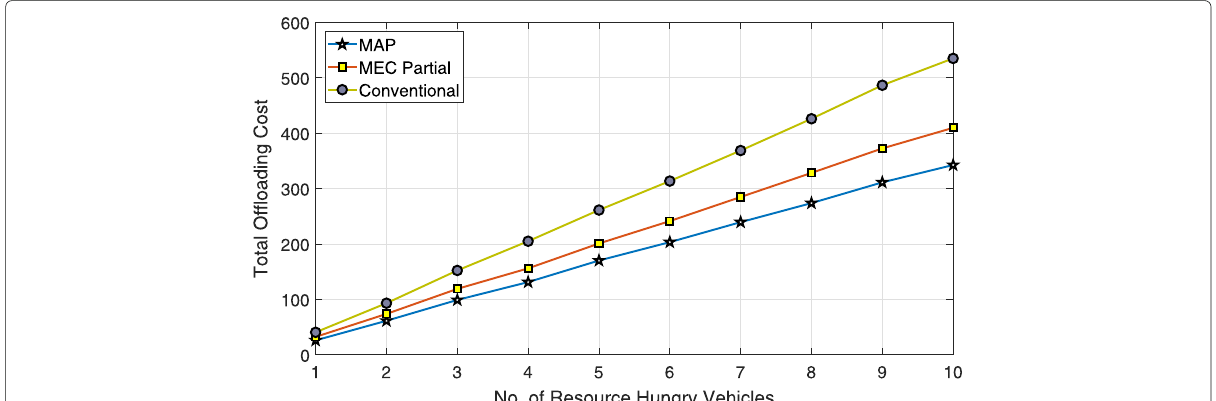
Fig. 2 The total offloading cost in terms of varying RHVs, when